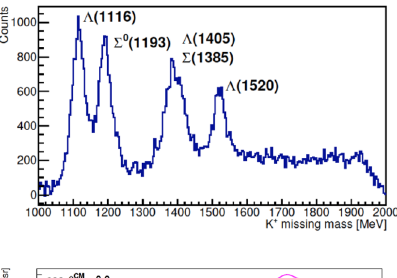
Figure 7. Preliminary di ff erential cross sections for the reactions γ p → K + Σ 0 (top) and γ p → K + Λ g. s . g. s . (bottom). Forward going kaons are detected in the OD spectrometer. Black points represent the preliminary new BGO-OD data. For comparison older CLAS data is plotted in green [20] and blue [21], and SAPHIR in red [22] . The magenta line shows the present BnGa partial wave fit, essentially to the newer CLAS data. Lacking most forward acceptance, CLAS data is in the cos θ cm K + 0 . 85 to 0 . 95 interval.